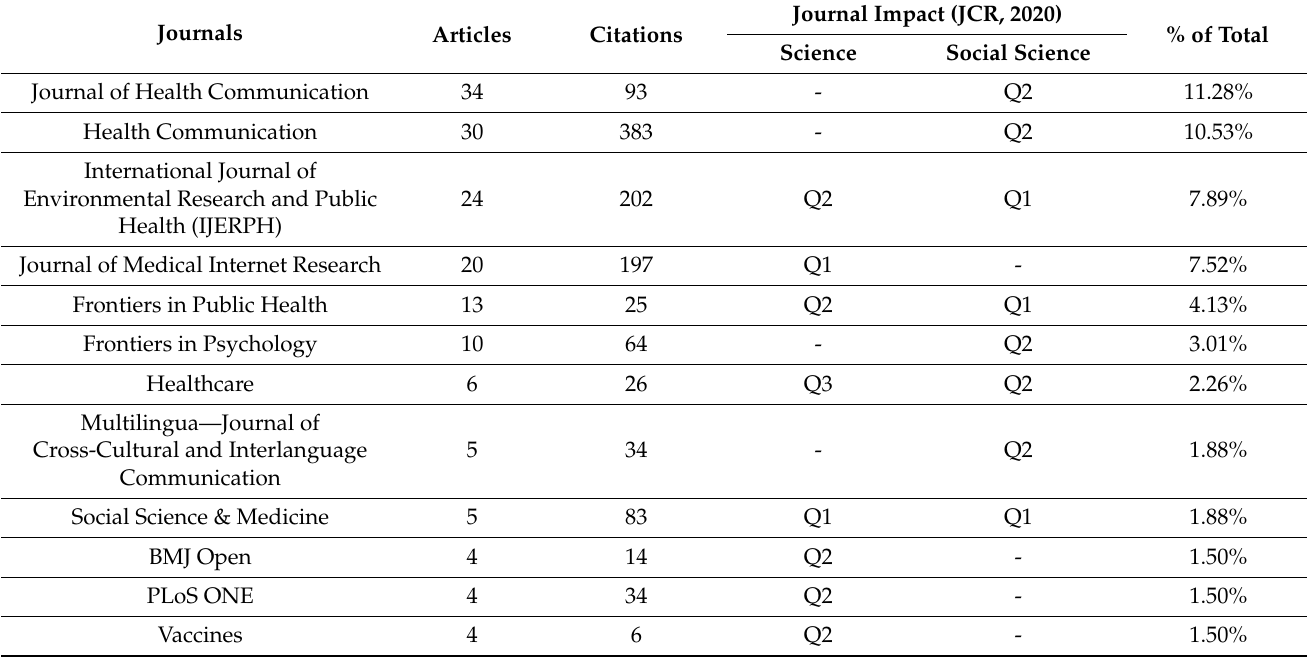
Table 4. Ranking of leading journals with articles on COVID-19 and health